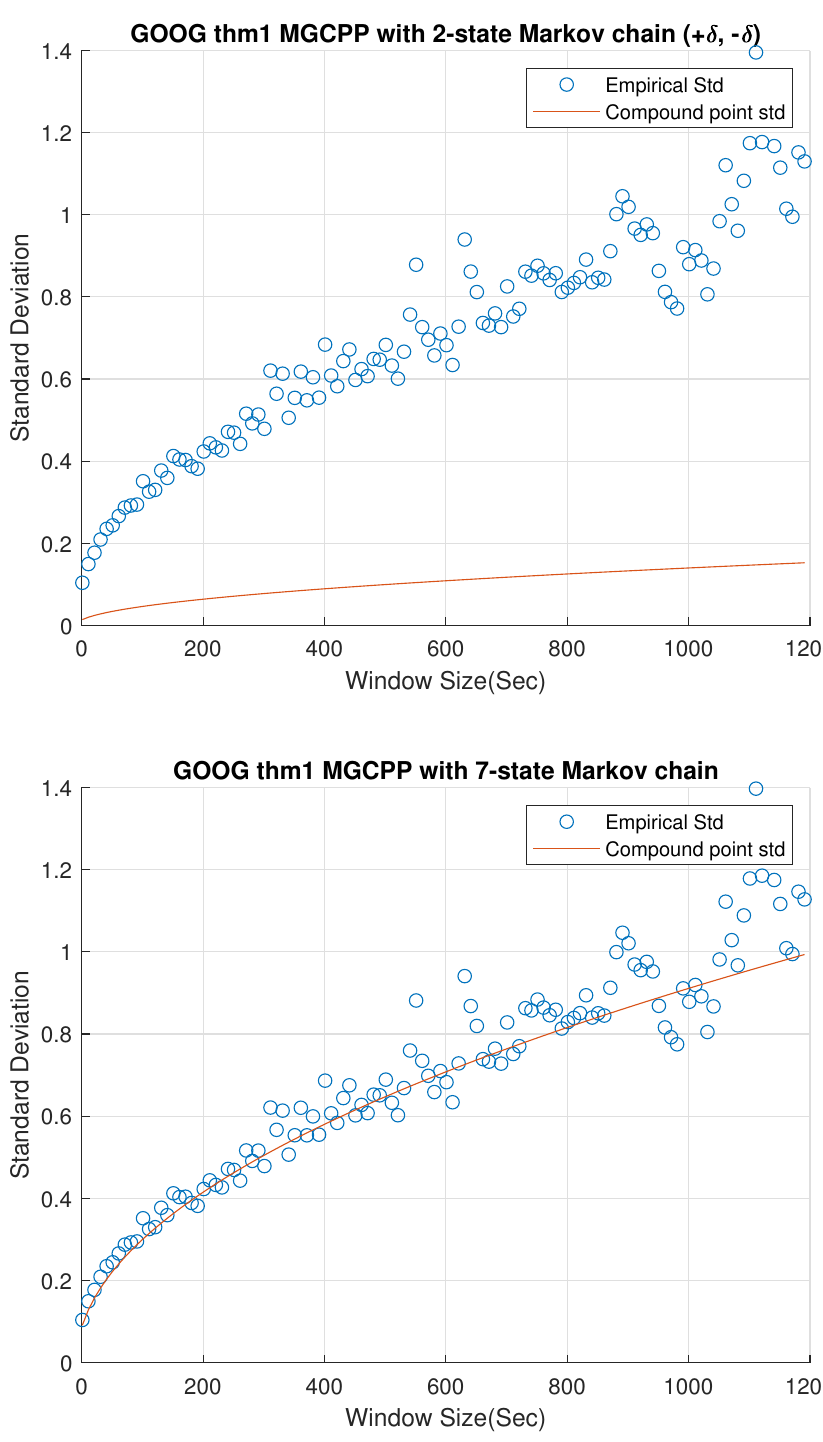
Figure 3. Standard deviation comparisons for MGCPP with 2-state Markov chain and 7-state Markov chain simulated by Google’s stock